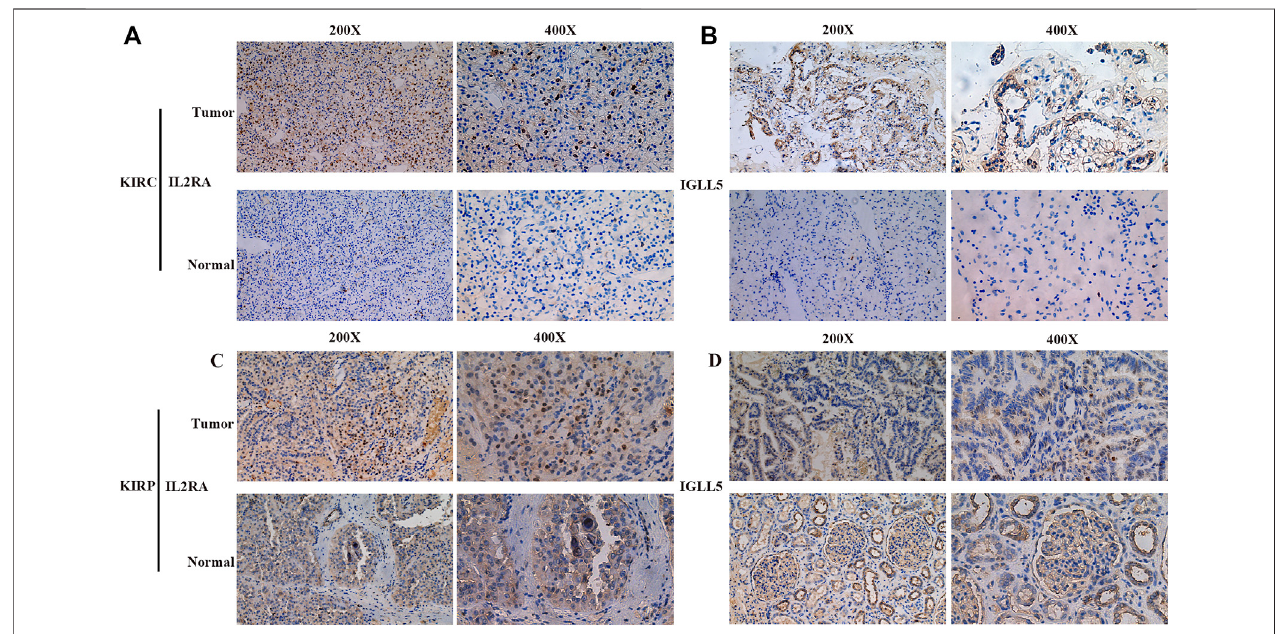
FIGURE 6 | Representative IHC images of IGLL5 and IL2RA in ccRCC and pRCC samples. (A,B) IHC patterns for IL2RA ( A ) and IGLL5 (B) in normal and KIRC samples. (C,D) IHC patterns for IL2RA (C) and IGLL5 (D) in normal and KIRP samples.